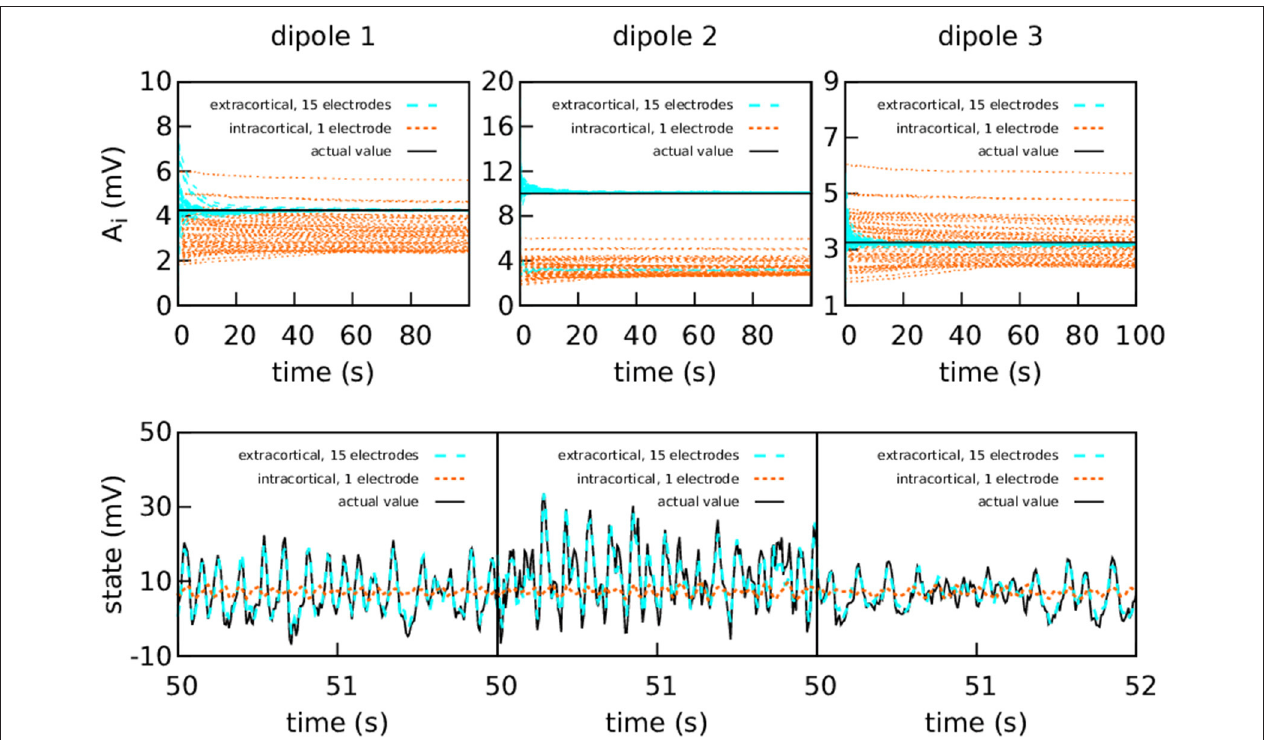
FIGURE 5 | Intracranial and extracranial fittings for coarse parameter estimation, with a higher amount of intracortical measurement noise. The upper panels show the estimation of the EPSPs for each cortical column and the lower panels show the estimations of the observed states. The results are shown here without averaging. The actual values of the amplitudes of the EPSPs are A 1 values ( Table 1 ). The external input p ( t ) for the three cortical columns had p 0 measurements were corrupted with Gaussian noise of mean 0 and standard deviation 100 mV—about an order of magnitude higher than the noise in the previous graph—, while the noise in the extracranial measurements has standard deviation 100 mV. Extracranial estimations of the parameters are also faster and more accurate than intracortical estimations, more markedly so in this case; as to the state, in this more extreme case, the intracortical estimation does not mimic the evolution of the system in any